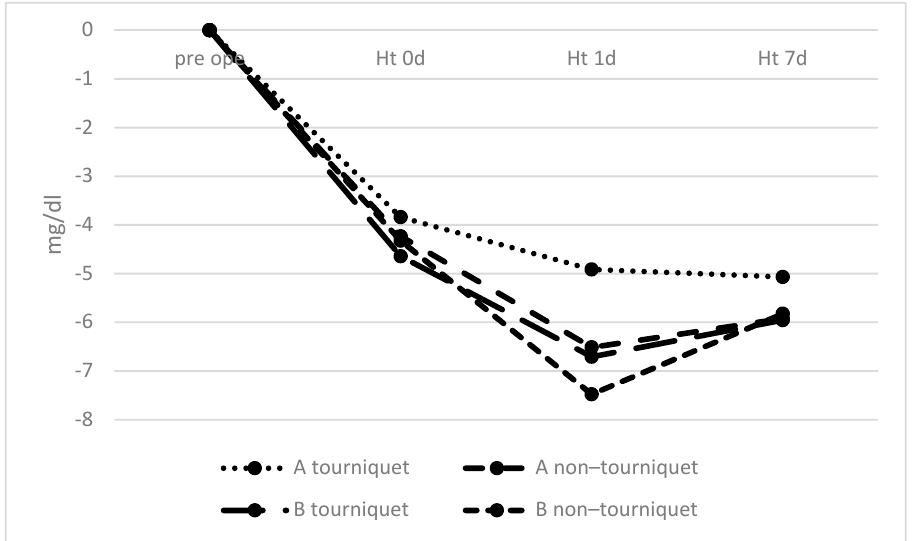
Figure 2. Changes over time in hematocrit levels. There was a significant difference in hematocrit levels at 1 day postoperatively between tourniquet group A and non–tourniquet group B.